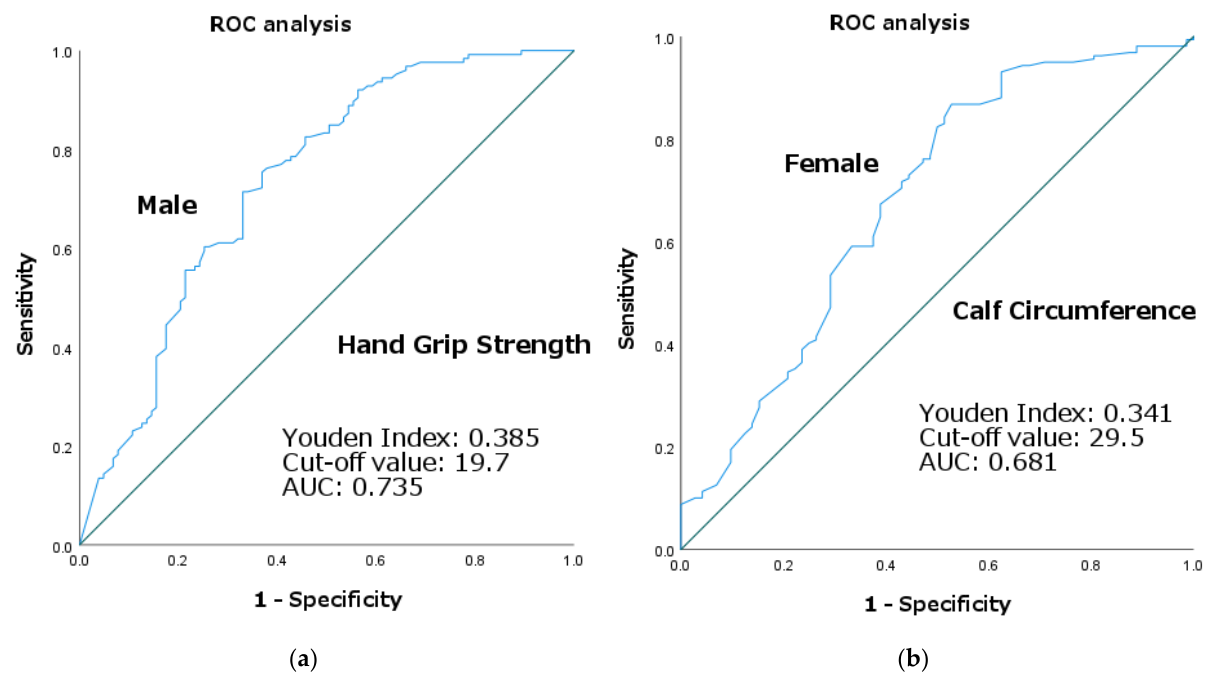
Figure 2. ROC curve analysis of: ( a ) handgrip strength in males, ( b ) calf circumference in females.